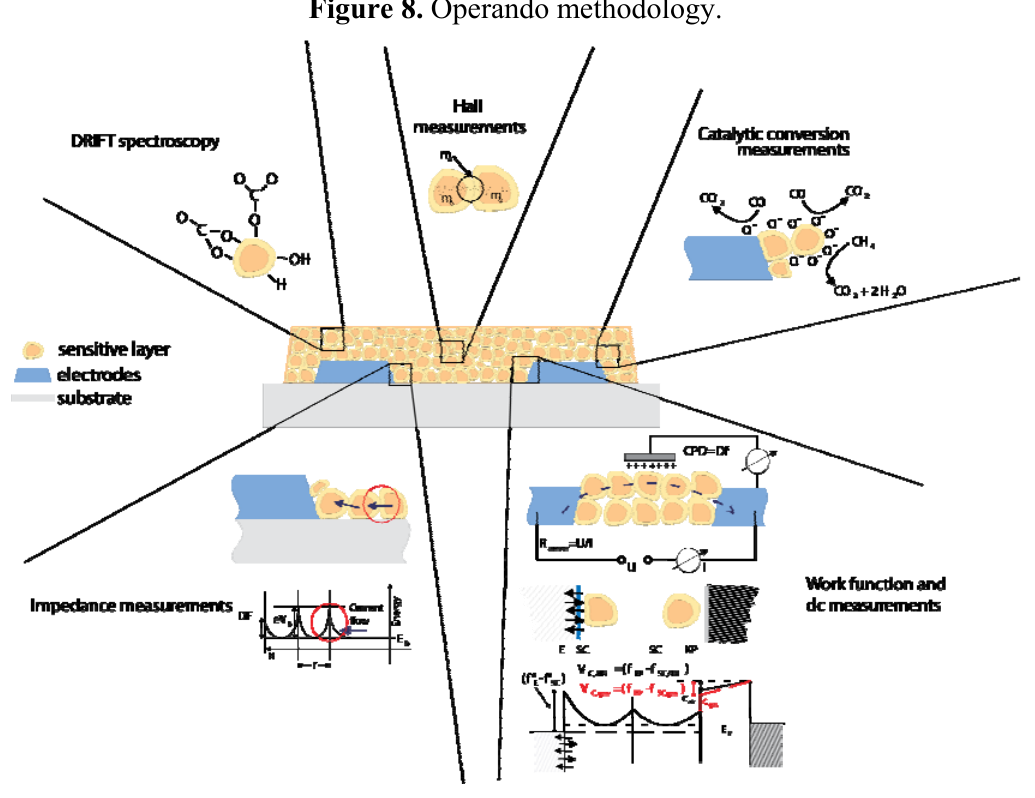
Figure 8. Operando